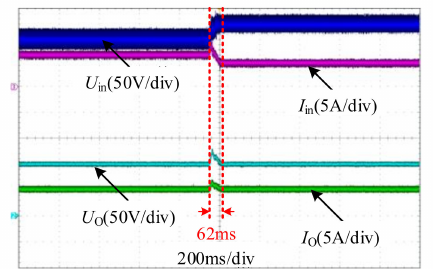
Figure 12. Changes of U C2 with primary and secondary side self-inductance before and after mis- alignment in